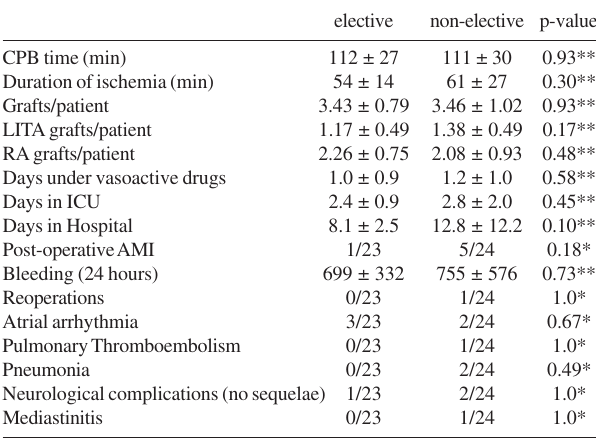
Table 2 - Operative and post-operative characteristics of studied patients